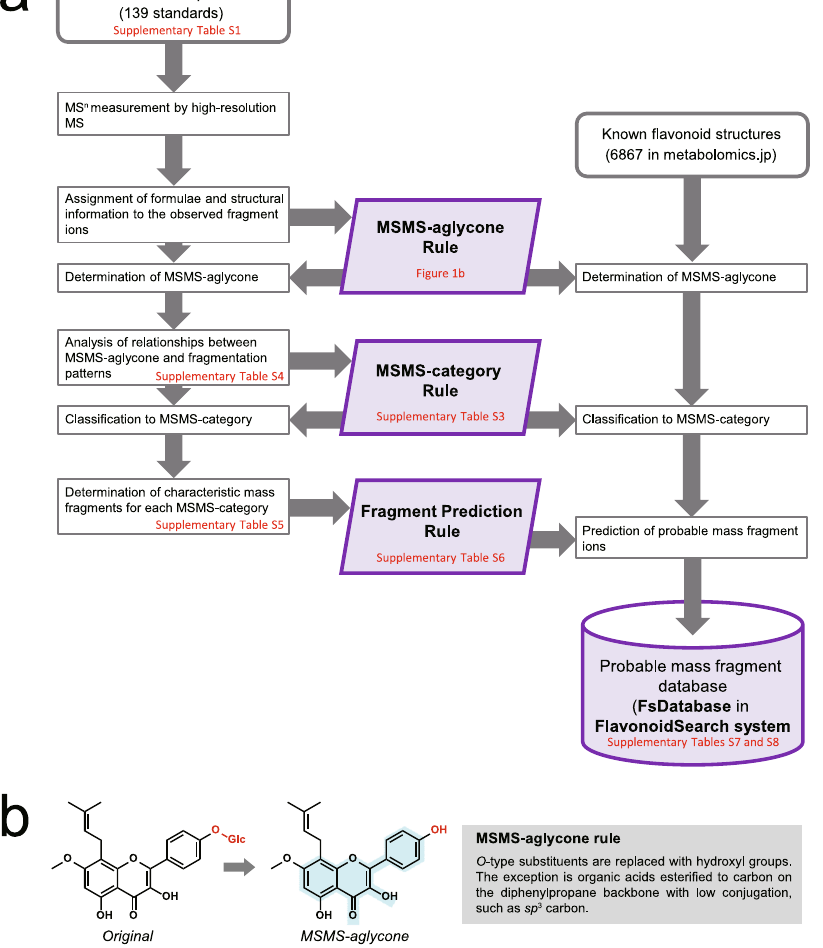
Figure 1. Construction of the probable mass fragment database of flavonoids (FsDatabase) for use in the FlavonoidSearch system. ( a ) Schematic outline of the construction of the FsDatabase. We analysed 139 authentic flavonoids and used the data to develop the following three rules: (1) the MSMS-aglycone rule to define the base structural unit of fragmentation (MSMS-aglycone); (2) the MSMS-category rule to define fragmentation patterns that were characteristic of flavonoid classes (Fig. 1b); and (3) the fragment prediction rule to identify probable fragments. These rules were used to create virtual fragments from 6,867 known flavonoids based on their chemical structures. References to related figures and tables are given in red. ( b ) The MSMS-aglycone rule (in the grey box) and an example of an MSMS-aglycone (right). According to the rule, the O -glucosyl group in the original structure (left) was replaced with a hydroxyl group. The C 6 -C 3 -C 6 backbone structure is highlighted in pale